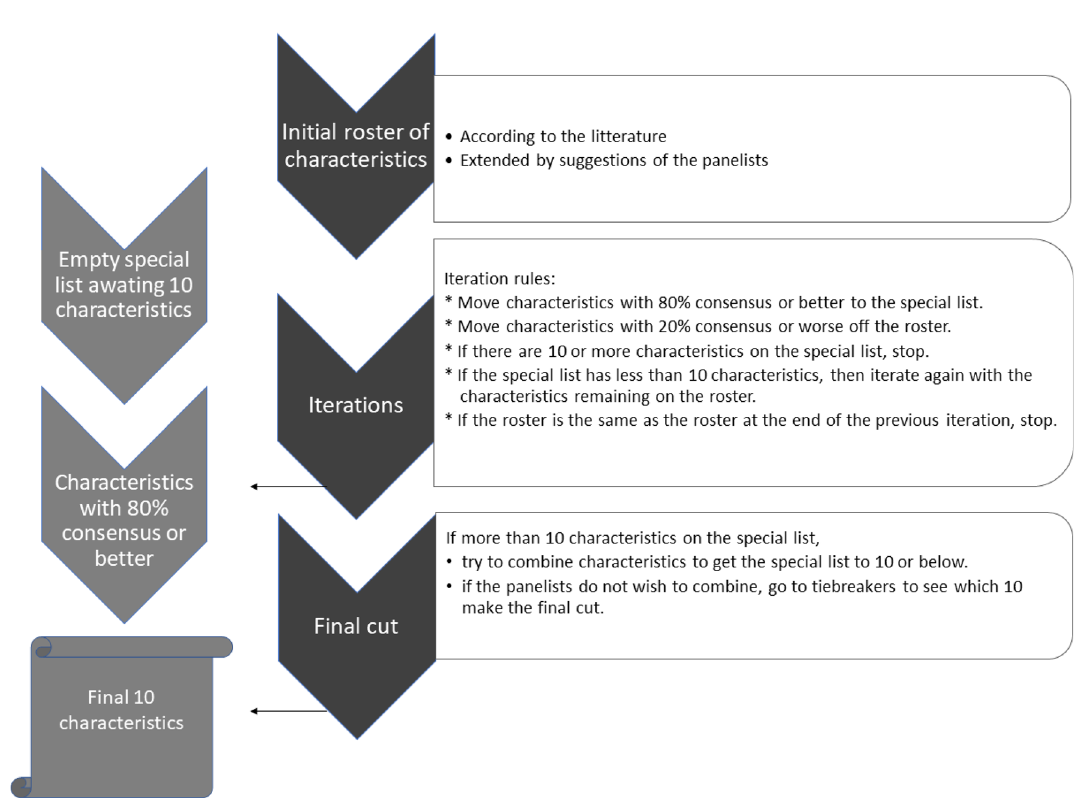
Figure 1. Delphi process and